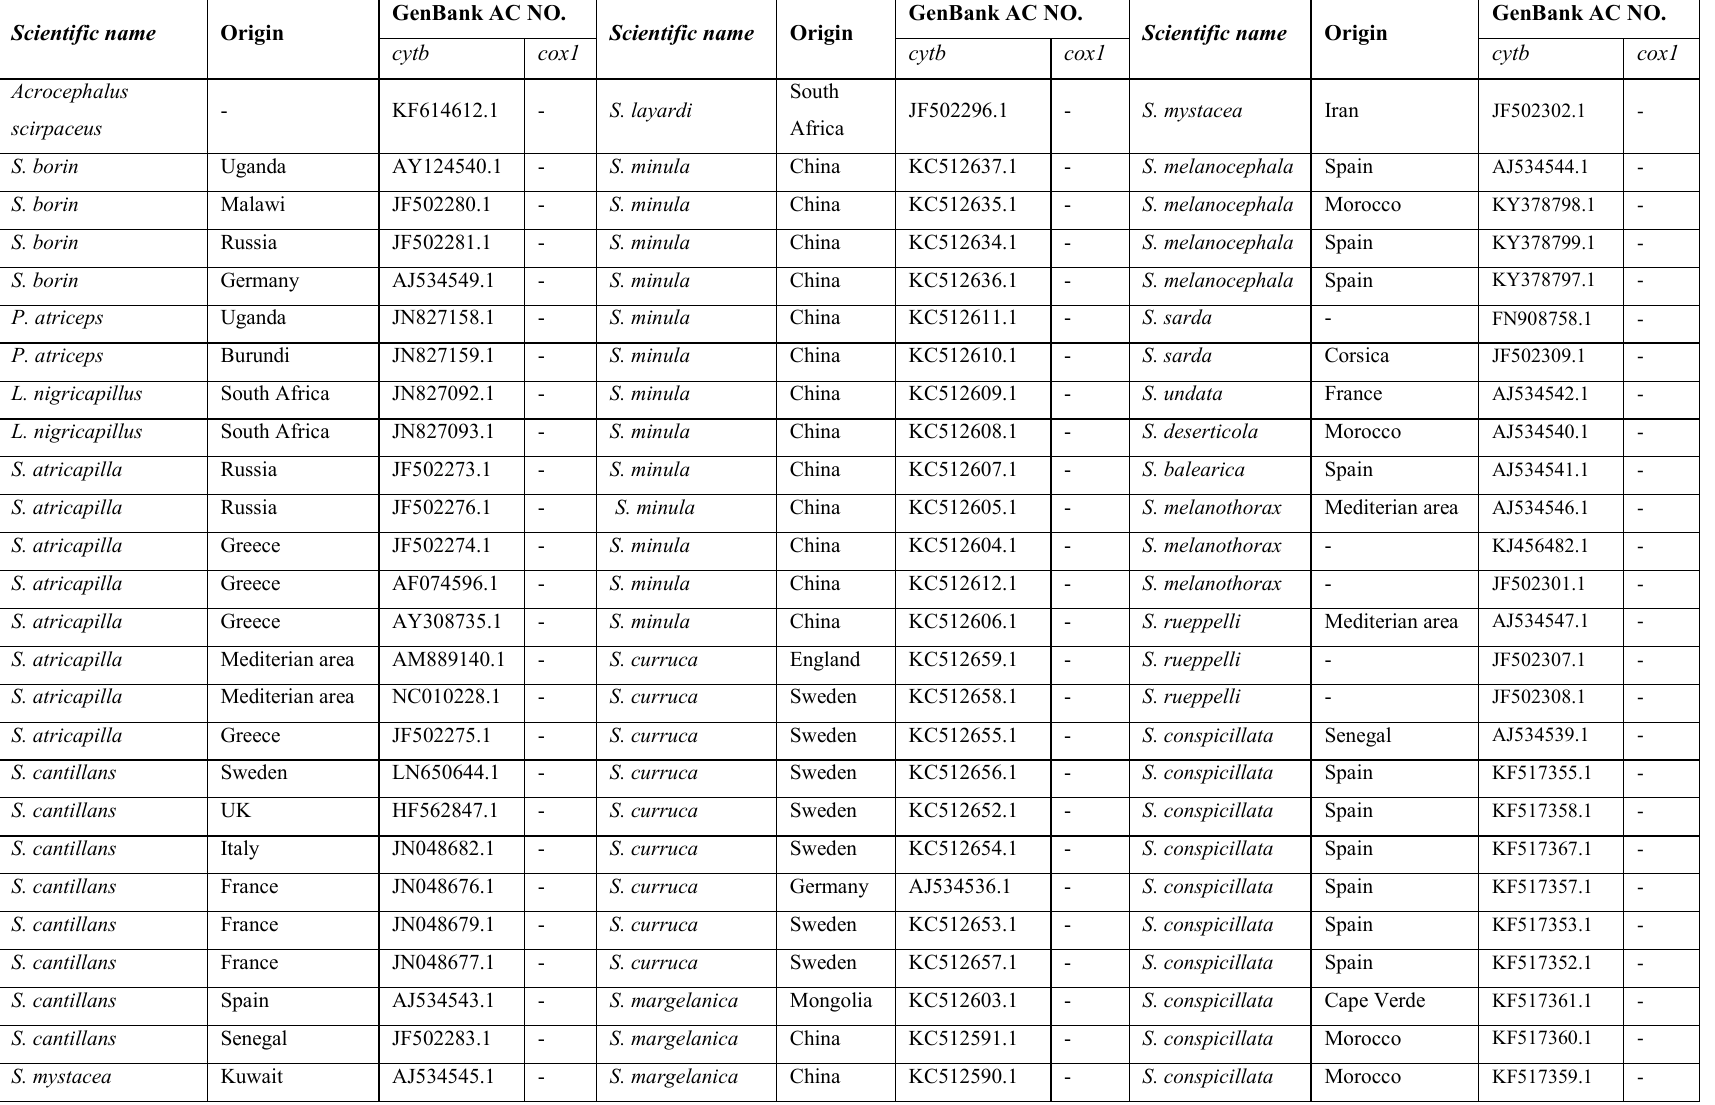
Table 2. The information of GenBank dataset for Iranian Sylvia